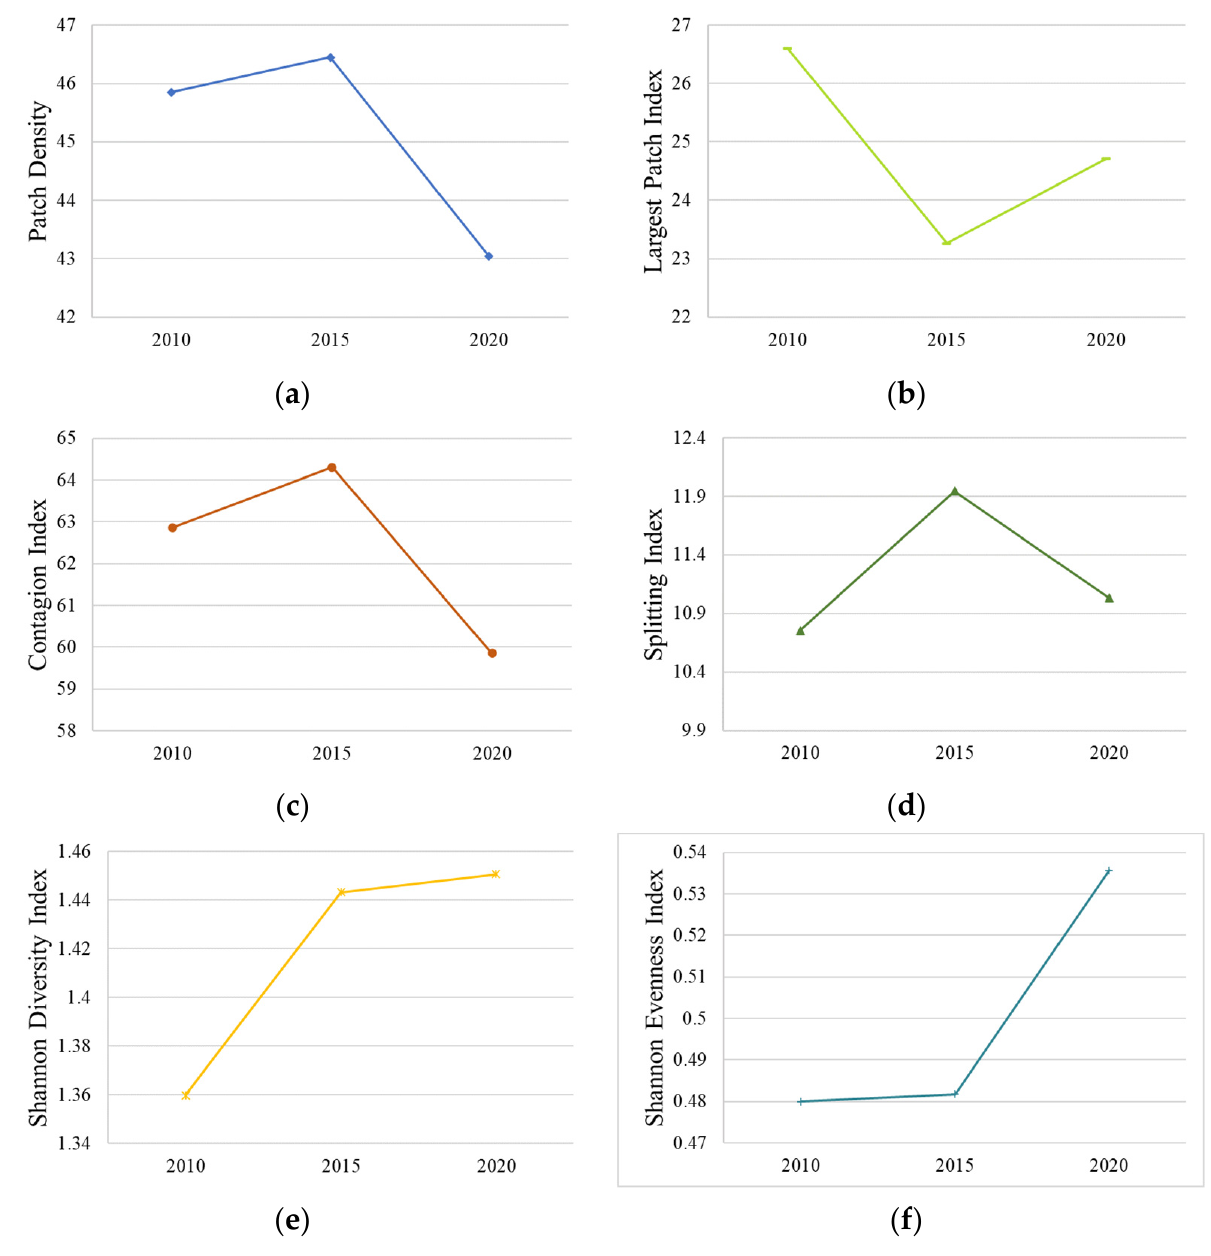
Figure 3. Landscape pattern index in Nanjing for three years. ( a ) PD values; ( b ) LPI values; ( c ) CON- TAG values; ( d ) SPLIT values; ( e ) SHDI values; ( f ) SHEI values.